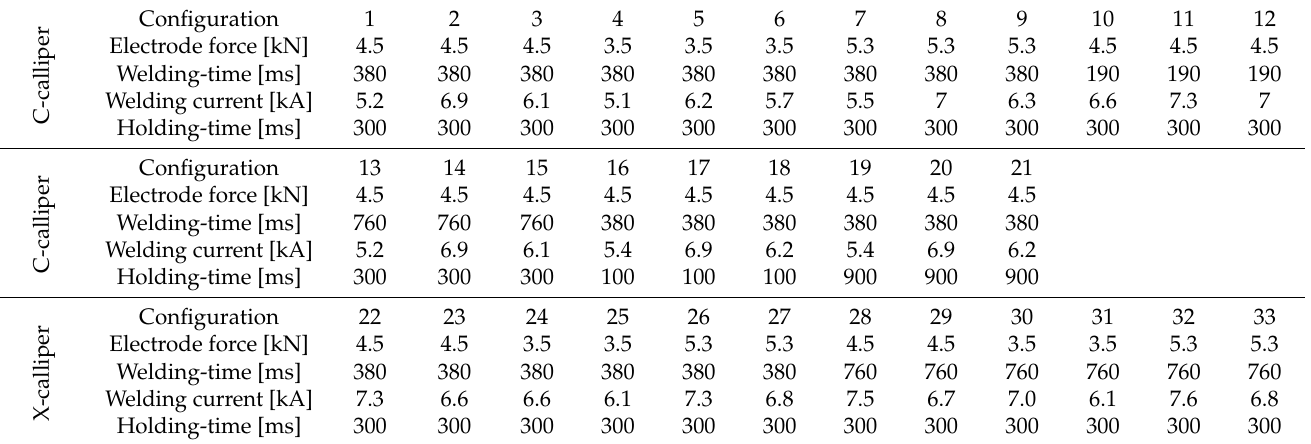
Table 2. Spot weld testing schedule applied for 1-, 2- and 3-sheet stack ups, respectively.